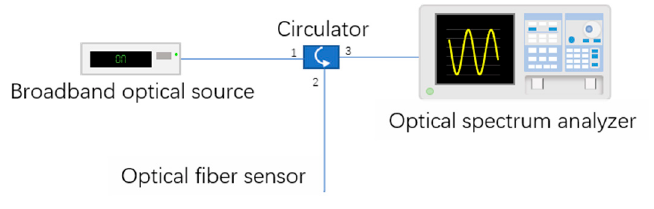
Figure 3. Experimental setup for the Fabry–Pérot interferometer characterization.